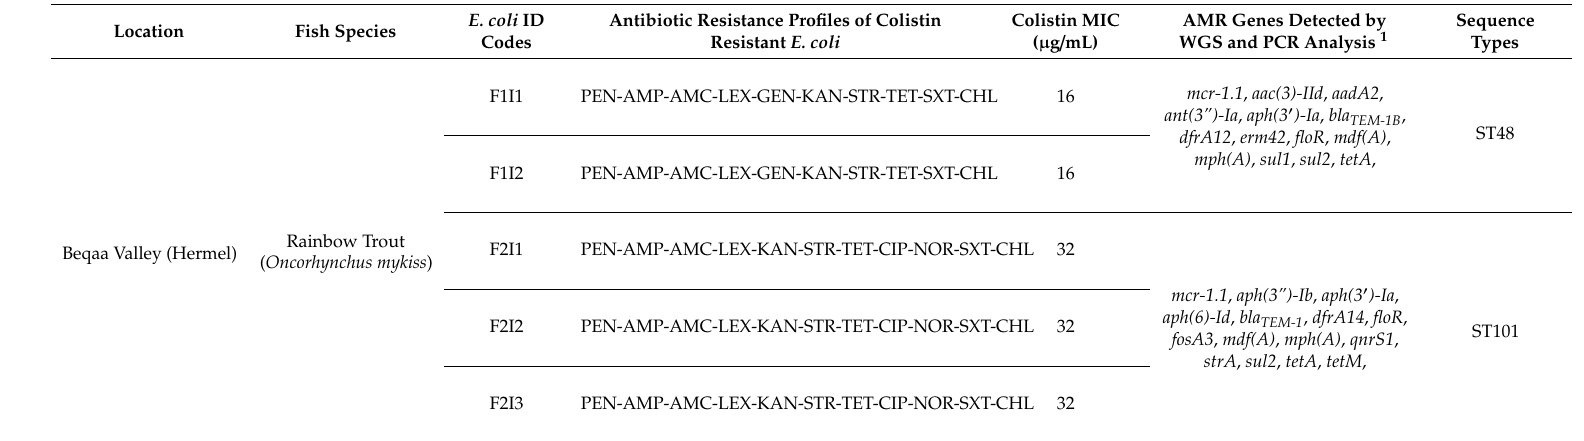
Table 2. Antibiotic resistance phenotypes and antimicrobial resistance (AMR) genes of the mcr-1 -positive and colistin-resistant E. coli isolated from Rainbow Trout